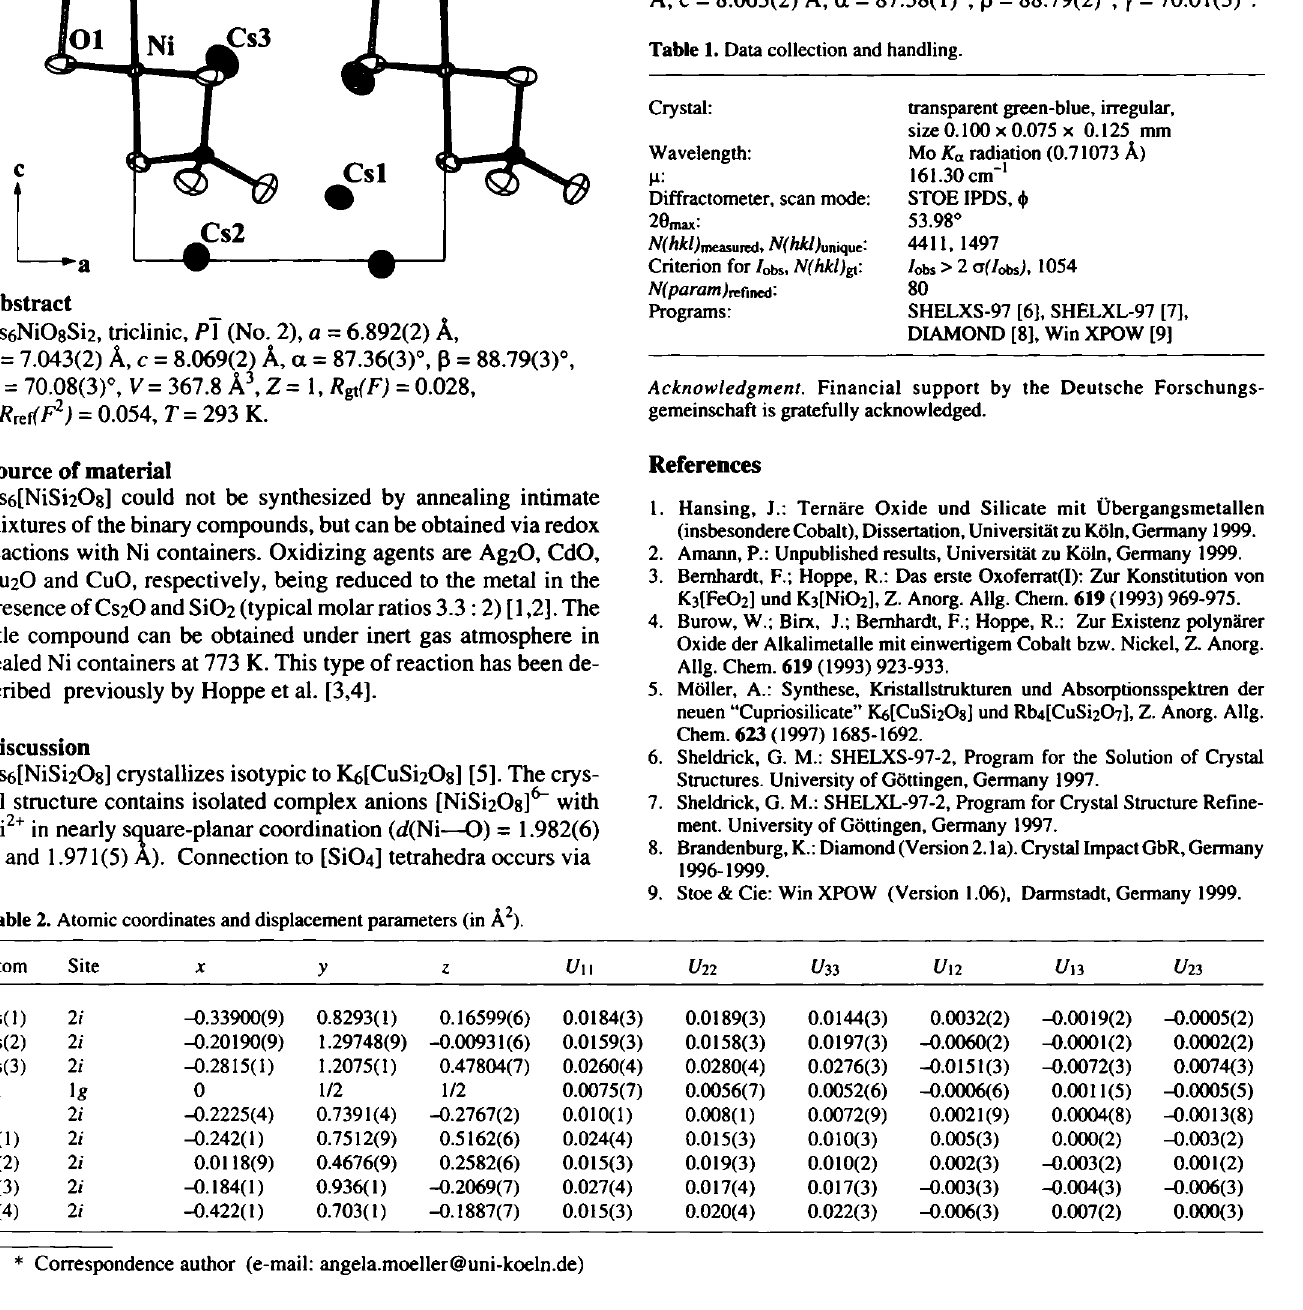
Table 1. Data collection and handling.